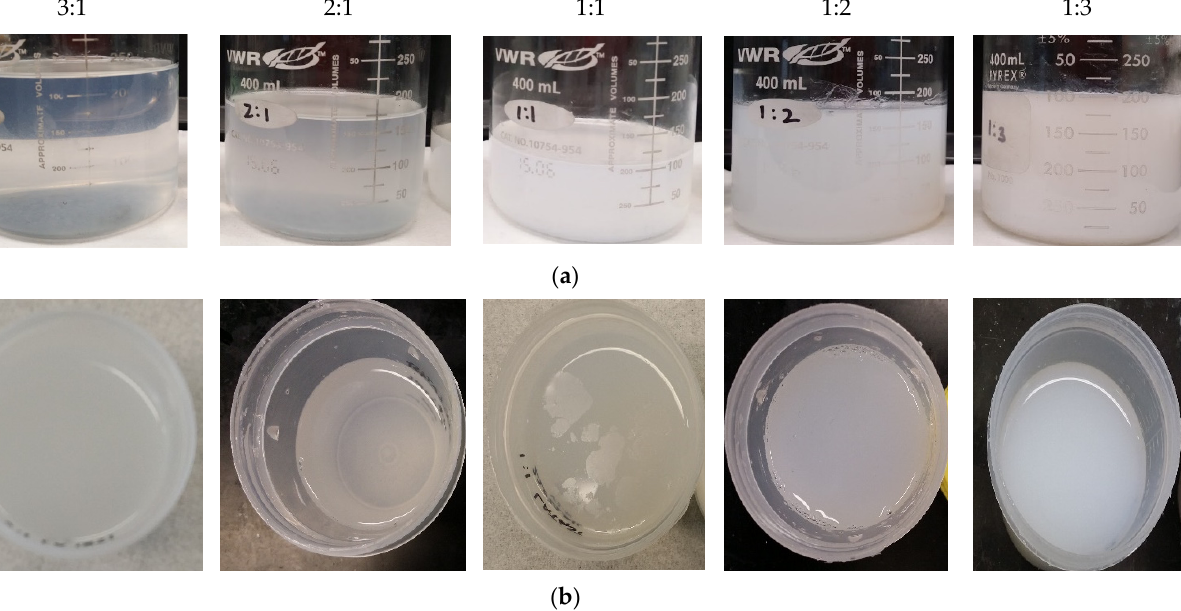
Figure 6. Pot-life for ( a ) TGST and ( b ) LA(TGST) solutions at crosslinking time t = 17 h.